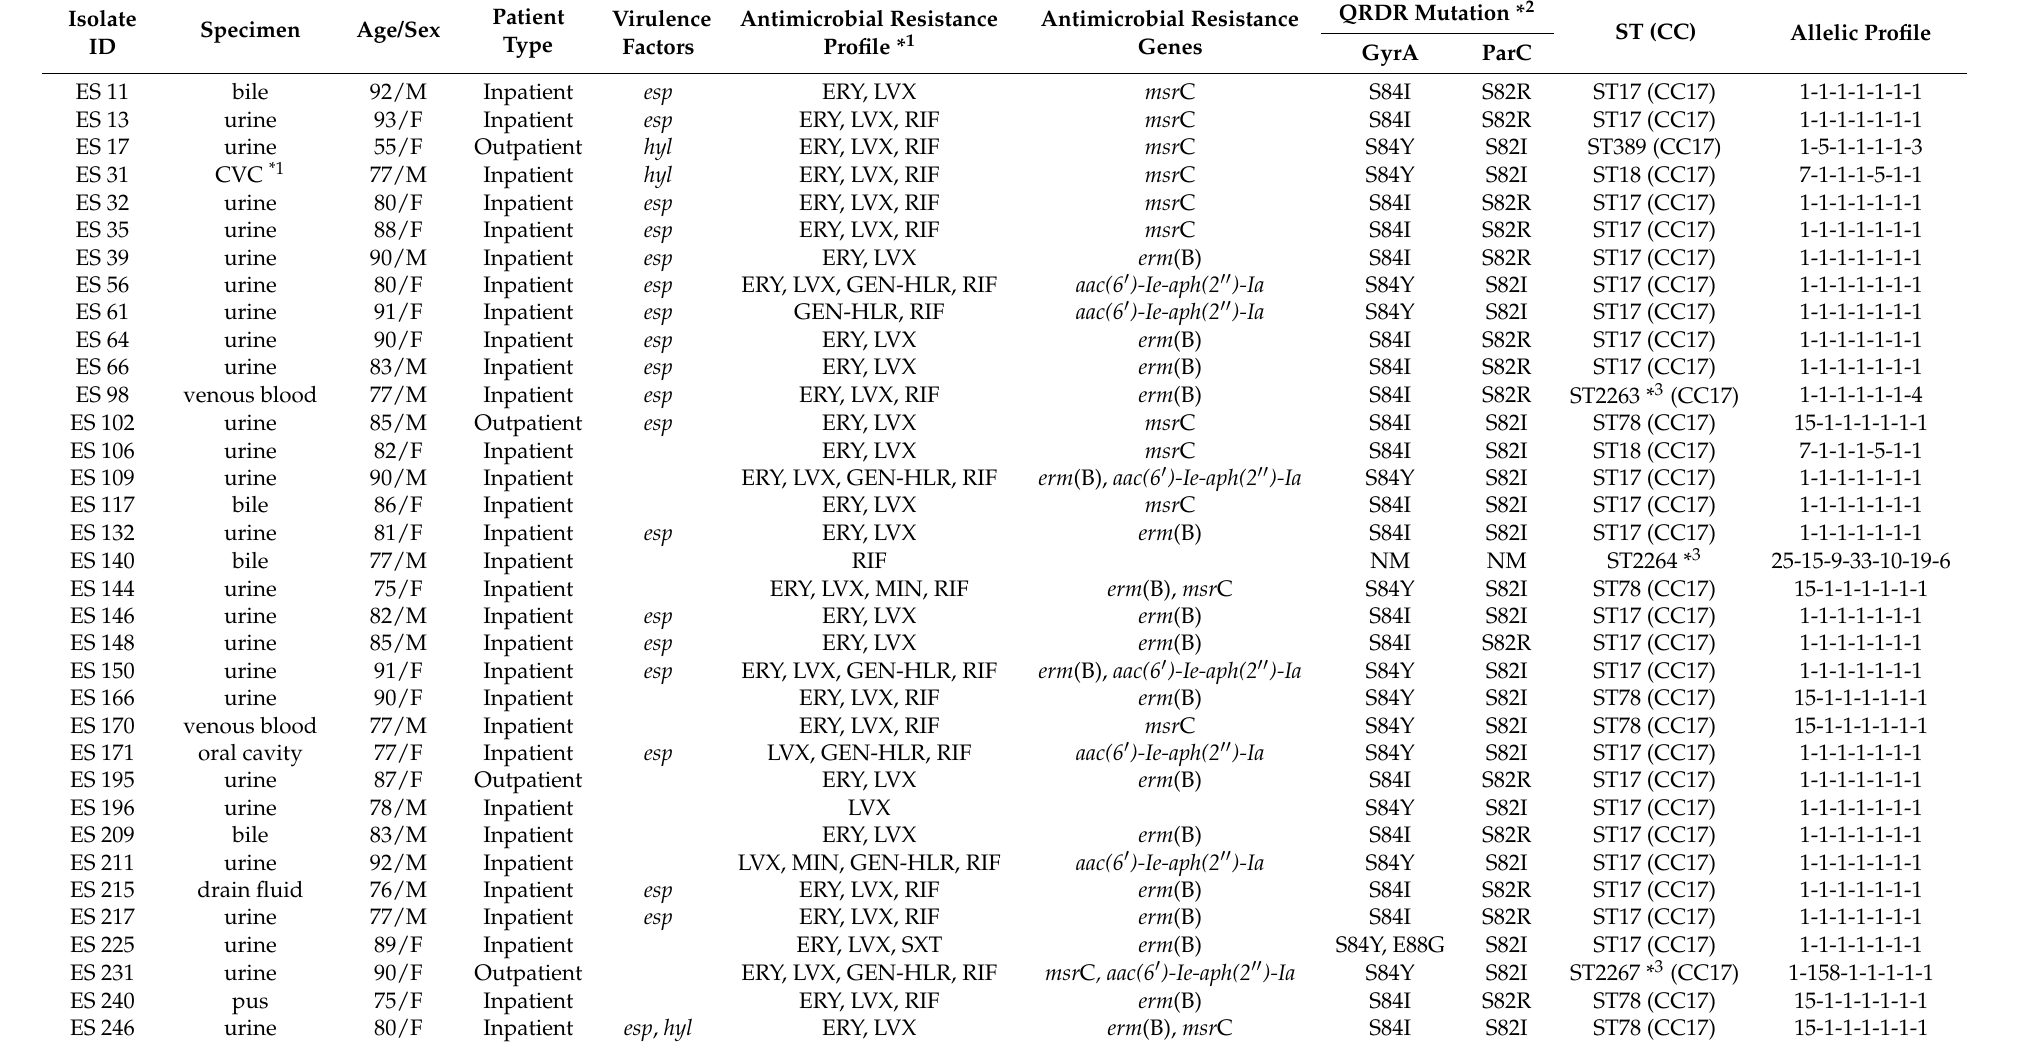
Table 5. Genotypes, virulence factors and antimicrobial resistance profile of all the E. faecium isolates (n =